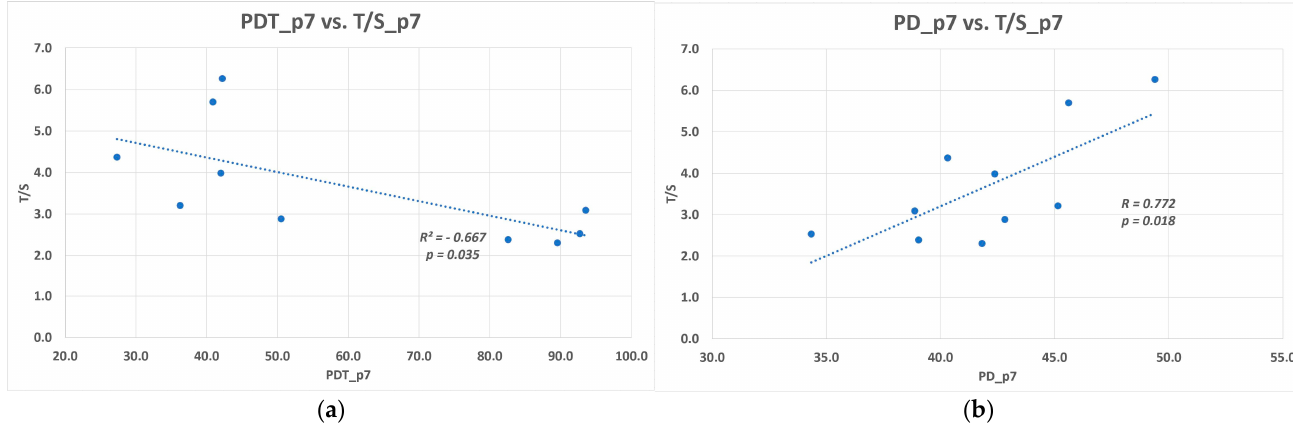
Figure 2. The relationship between the relative telomere length (T/S) and DPSCs kinetics in p7. The correlation coefficients of a linear regression fit the shown data the best: ( a ) Plot of the (T/S) in p7 against doubling time (PDT) in the p7, and the regression line; ( b ) Plot of T/S in p7 against cumulative population doublings in the p7, and the regression line. The relative telomere length attrition versus lower count of PDs and longer PDT among each DPSC lines were also found to be statistically significant (Figure 3).